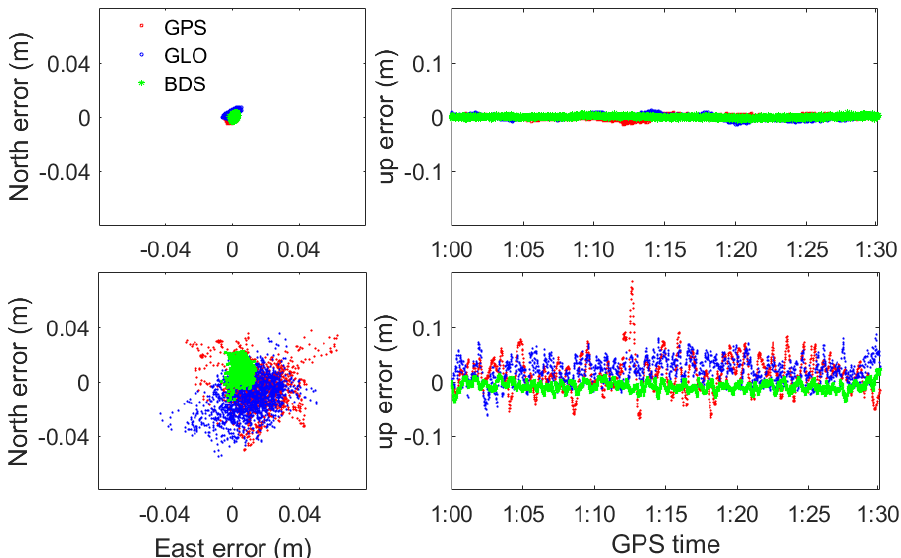
Figure 2. Real-time kinematic (RTK) position errors resulting from synchronous ( top ) and asynchronous ( bottom ) data in Session A1 for Bs.1.